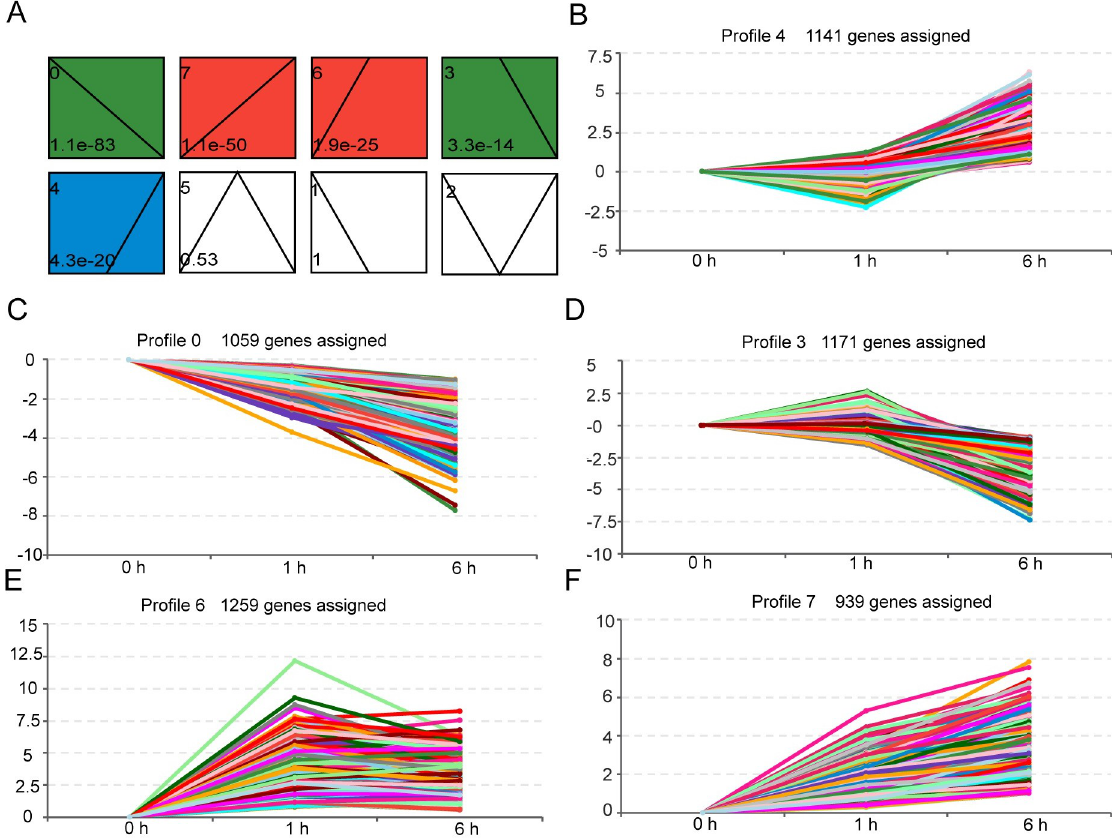
Fig 2. Patterns of gene expression across three time points in C . wenyujin with MeJA treatment. (A) Expression trend clustering of all DEGs. Each rectangle represents a profile. Profiles with the same color can be grouped into the same cluster. The colorless rectangle indicates that clustering is not significant. The number in the upper left corner of the rectangle is the number of profile, in which the broken line is the trend of expression over time. The p -value in the lower left corner reflects the corresponding significance level. (B-F) Expression patterns of each significant clustering profile. The number of unigenes in each profile is labeled above the frame. Broken lines represent the trend of gene expression. The numbers on the x-axis indicate the time points of 0, 1, and 6 h, respectively. The numbers on the y-axis represent up-regulation ( > 0), no change (= 0), and down-regulation ( < 0),